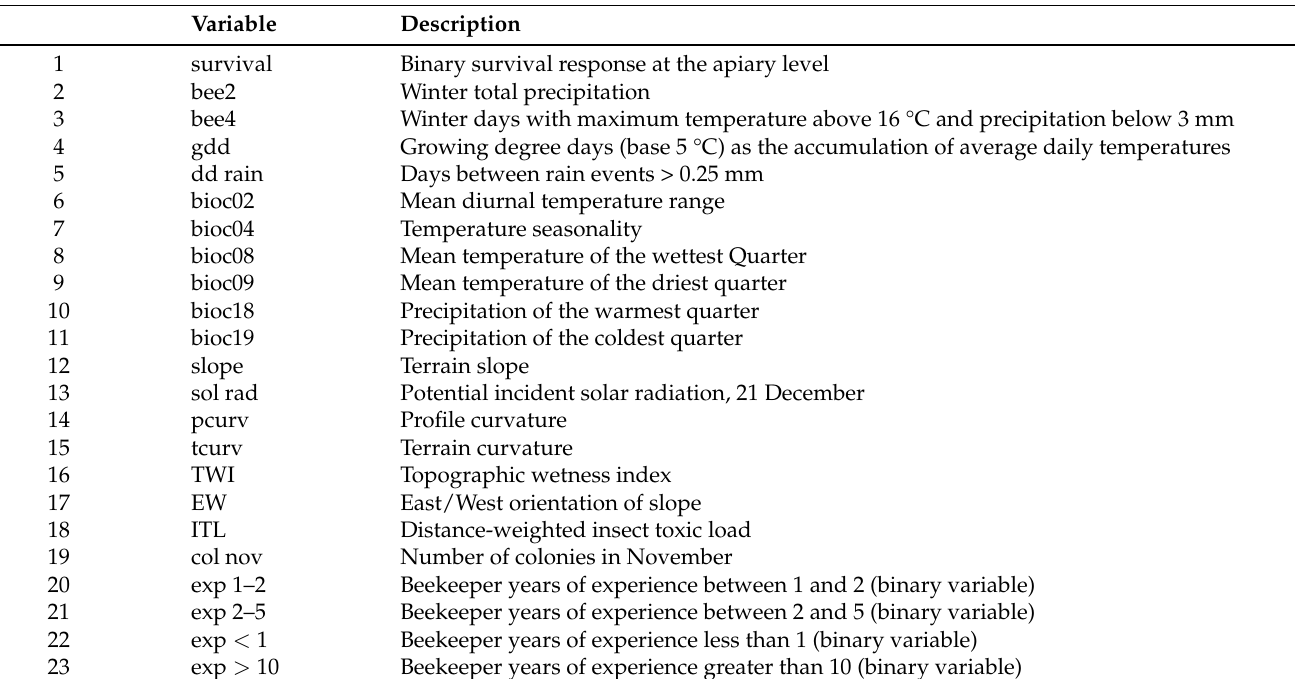
Table 2. Description of the features included in our logistic model formulation to describe honey bee overwintering survival. See [18] for details. The bioc# variables refer to bioclimatic variables of the WorldClim database; see